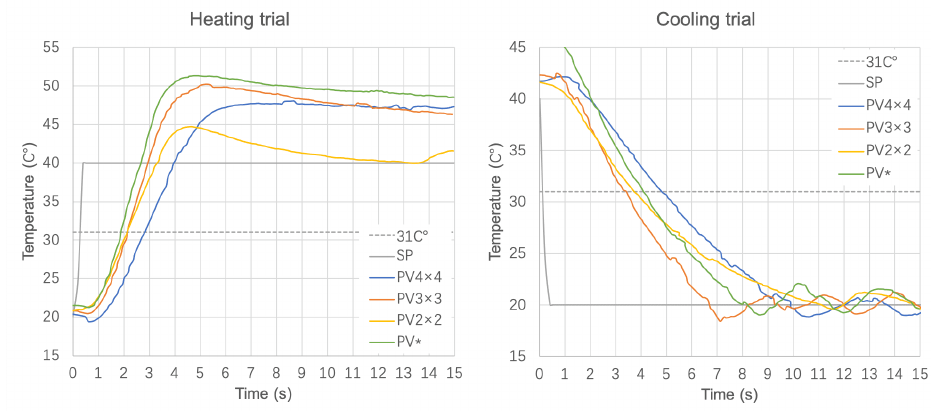
Figure 8. The surface temperature-changing curves of the Peltier element in heating ( left ) and cooling ( right ) trial. SP stands for the temperature set point. PV stands for the process value of the Peltier surface temperature, the number that follows “PV” stands for the Peltier size in Test Group One, and the * symbol stands for Test Group Two.